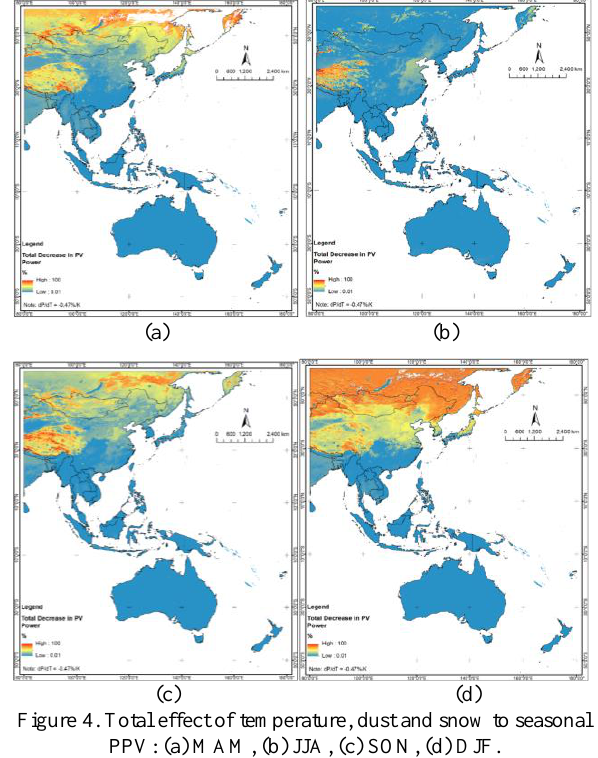
Figure 4. Total effect of temperature, dust and snow to seasonal